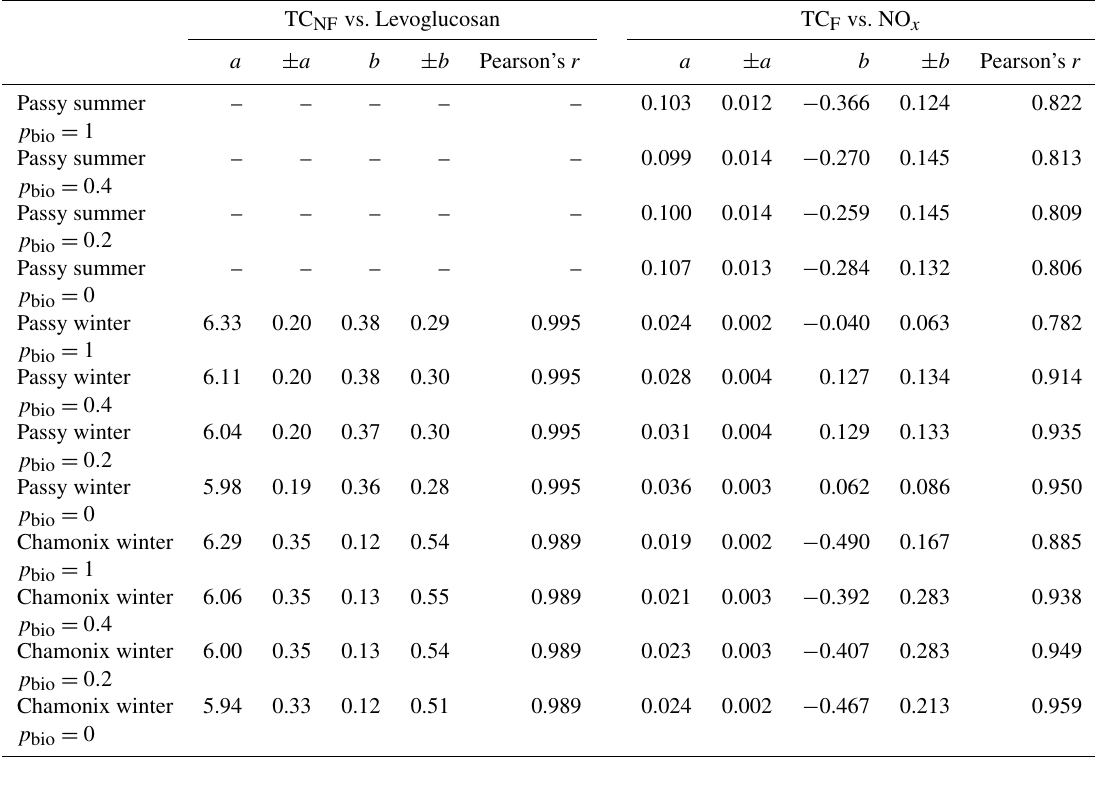
Table 5. Determination of the linear fit parameters (with their 95% confidence intervals) for the linear relation between TC NF and levoglu- cosan, and for the linear relation between TC F and NO x . Variation in p bio and in TC NF and TC F does not have a major influence on the regression parameters in the case of TC NF vs. Levoglucosan but does in the case of TC F vs. NO x because of the small amount of TC F .